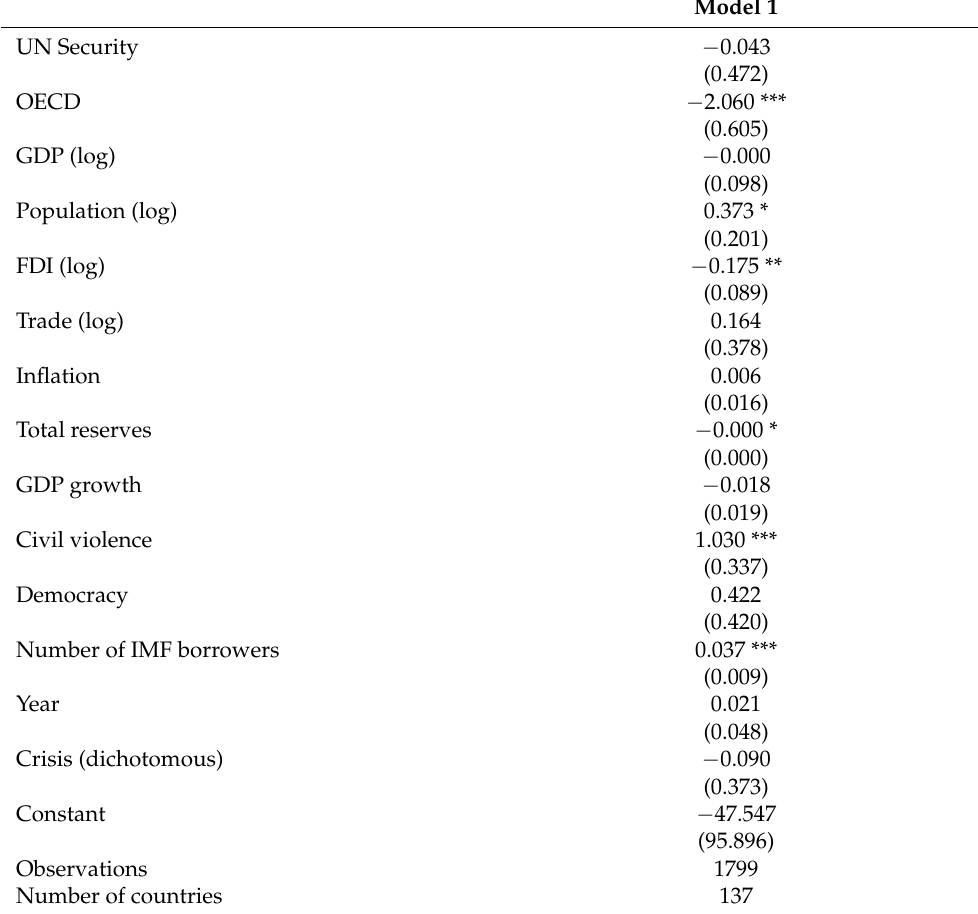
Table 1. Random Effects Logit Model. DV: 0 = Not Under IMF Lending 1 = Under IMF